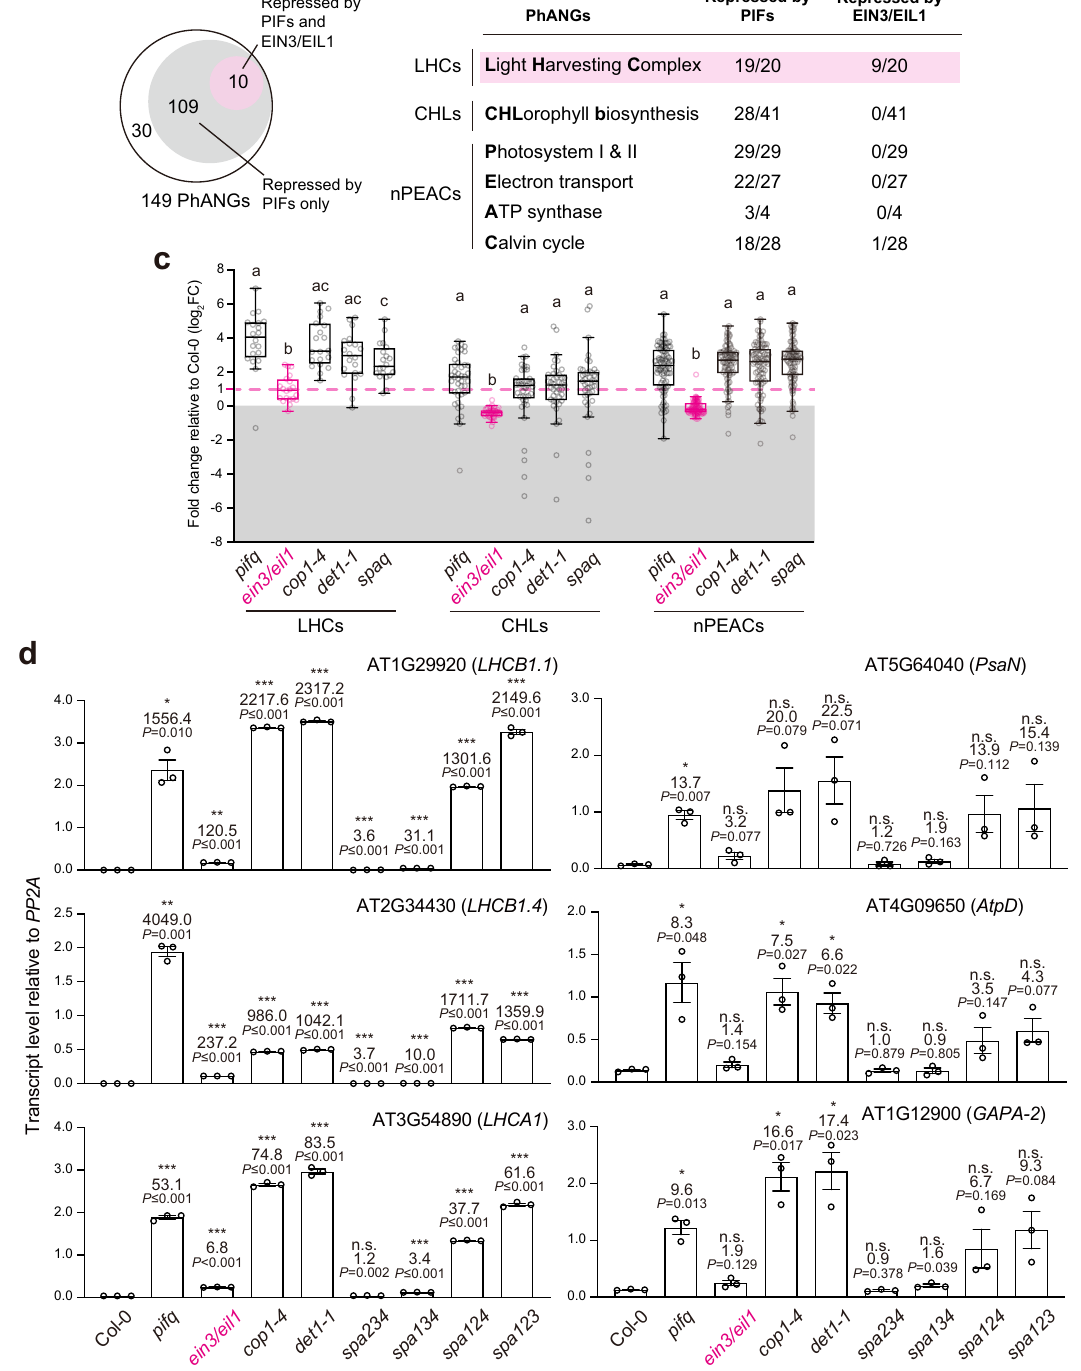
Fig.2|OnlyasubsetofPhANGsareconstitutivelyactivatedin ein3/eil1 .a Venn diagramshowingPhANGsrepressedbyPIFsandEIN3/EIL1indark-grownseedlings. b TableshowingthenumberofPIF-repressedandEIN3/EIL1-repressedgenesinthe PhANG subcategories. c Box-and-whisker plots showing the fold changes in LHCs, CHLs, and nPEACs in pifq , ein3/eil1 , cop1-4 , det1-1 , and spaq compared with Col-0 seedlings. Each data point represents a gene; data points above the dotted magenta line are statistically signi fi cantly upregulated in the mutants by at least two-fold. The lower and upper bounds of the box represent the 25th and 75th percentilerespectively;thecenterbarrepresentsthemedian.Thelowerandupper end of the whiskers represent minimum and maximum values respectively. Dots outsideofthewhiskersrepresentoutliersbasedonTukey ’ sfences.Differentletters denote statistically signi fi cant differences in gene expression among the mutants within each subcategory (ANOVA, Tukey ’ s HSD, P ≤ 0.05; n =3 biological